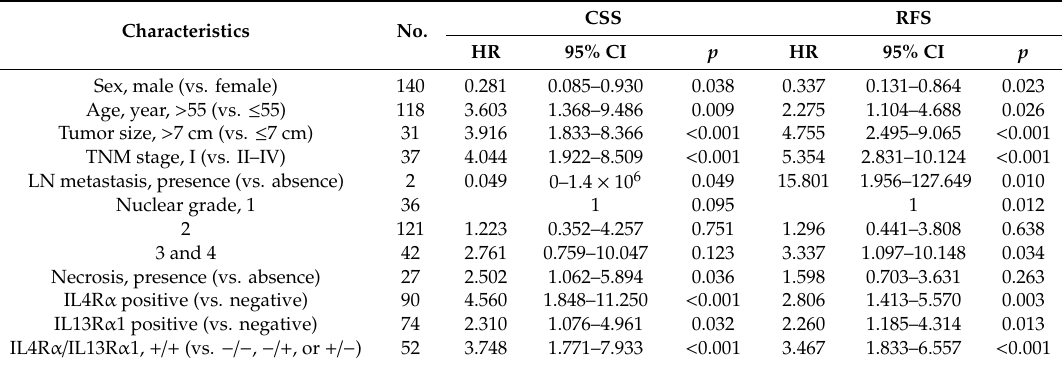
Table 2. Univariate Cox regression analysis of cancer-specific survival (CSS) and relapse-free survival (RFS) in clear cell renal cell carcinoma (CCRCC) patients.